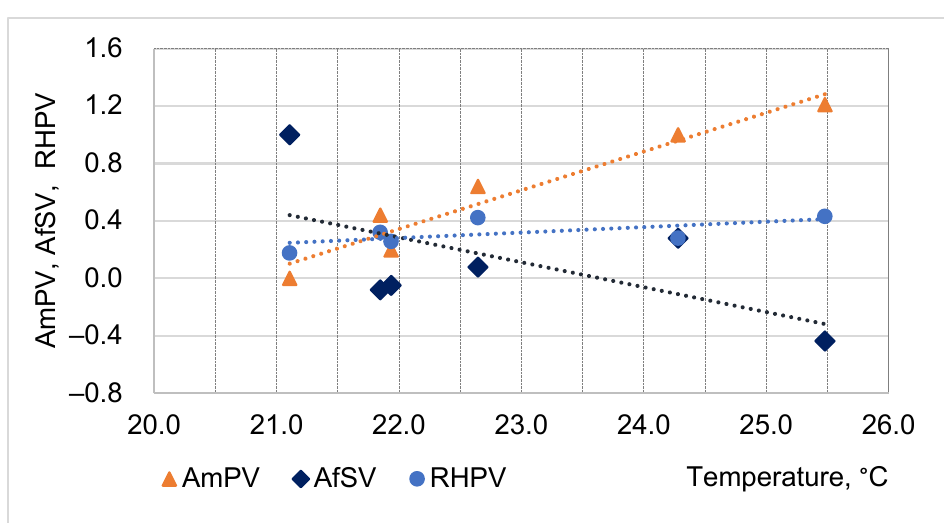
Figure 14. Relationship between Air Freshness Sensation Vote (AfSV), Air Movement Preferences Vote (AmPV), Relative Humidity Preference Vote (RHPV) and operative temperature T o .